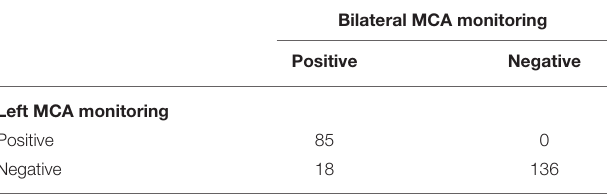
TABLE 3 | Comparison of right-to-left shunt detection by cTCD with LMCA and bilateral MCA monitoring.